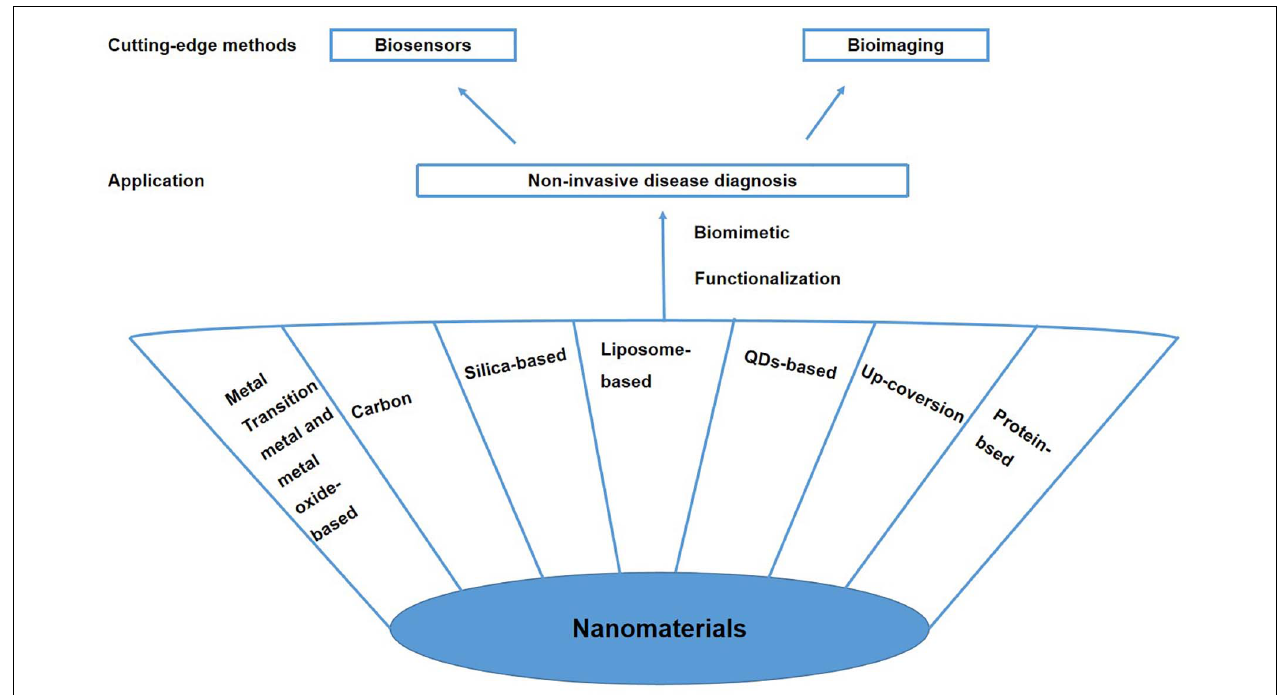
FIGURE 1 | Advanced biomimetic nanomaterials for non-invasive disease